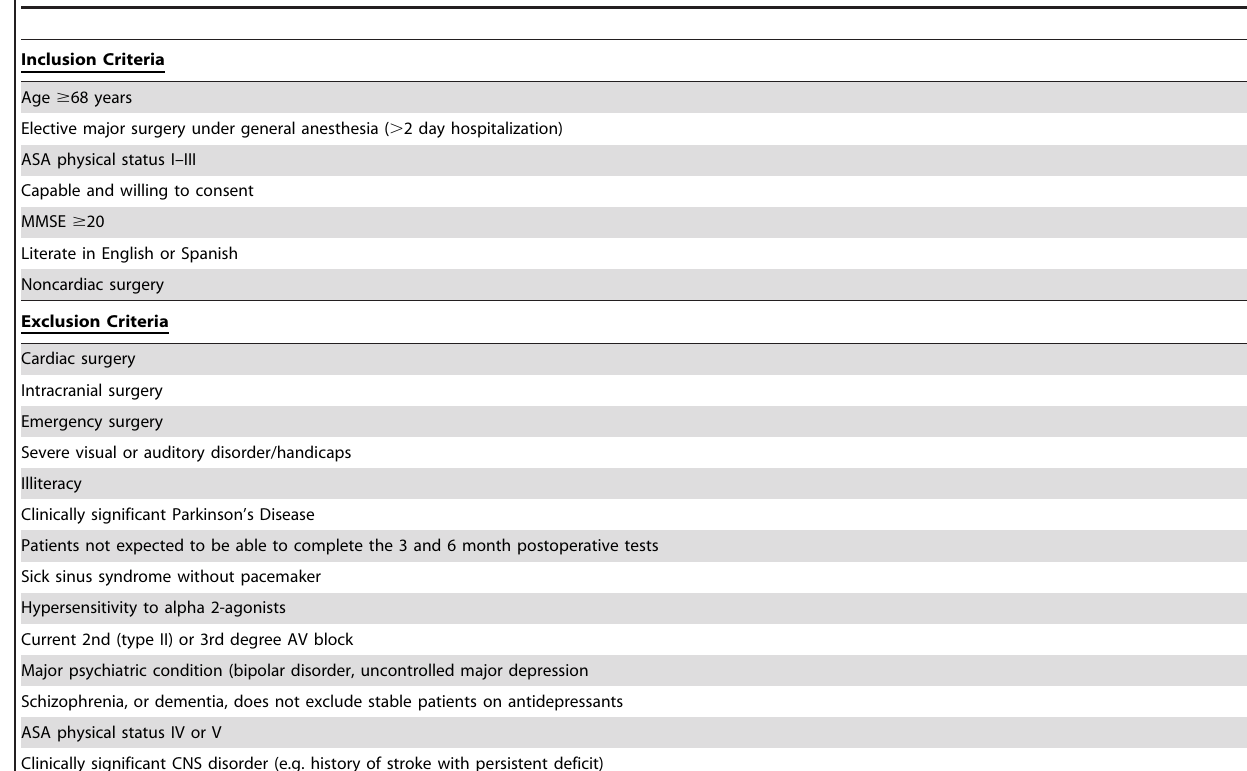
Table 1. Inclusion and Exclusion Criterion of the Parent